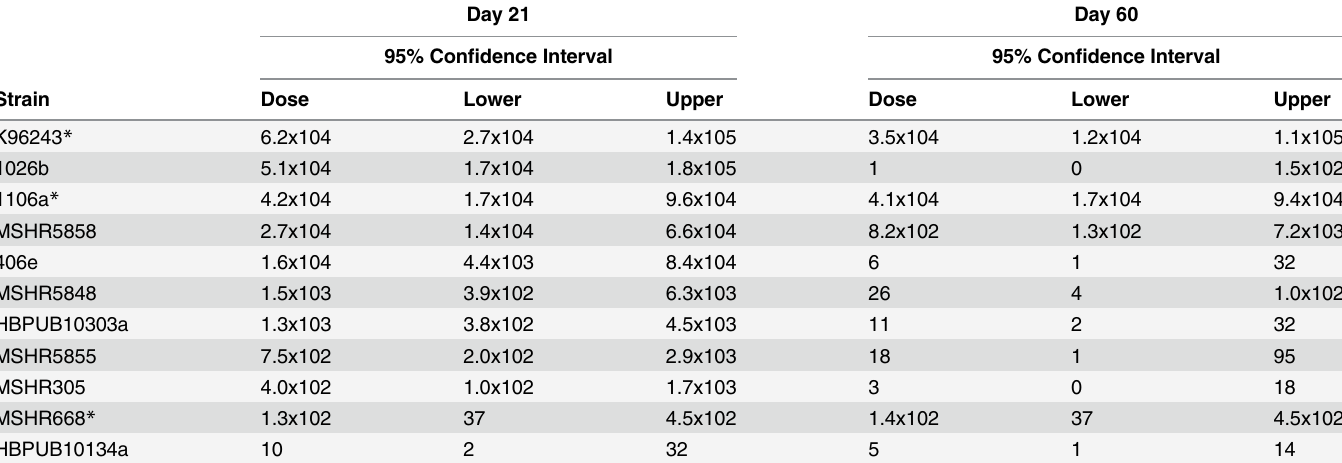
Table 1. Summary of LD 50 statistics for B. pseudomallei strains in BALB/c mice challenged by IP route.